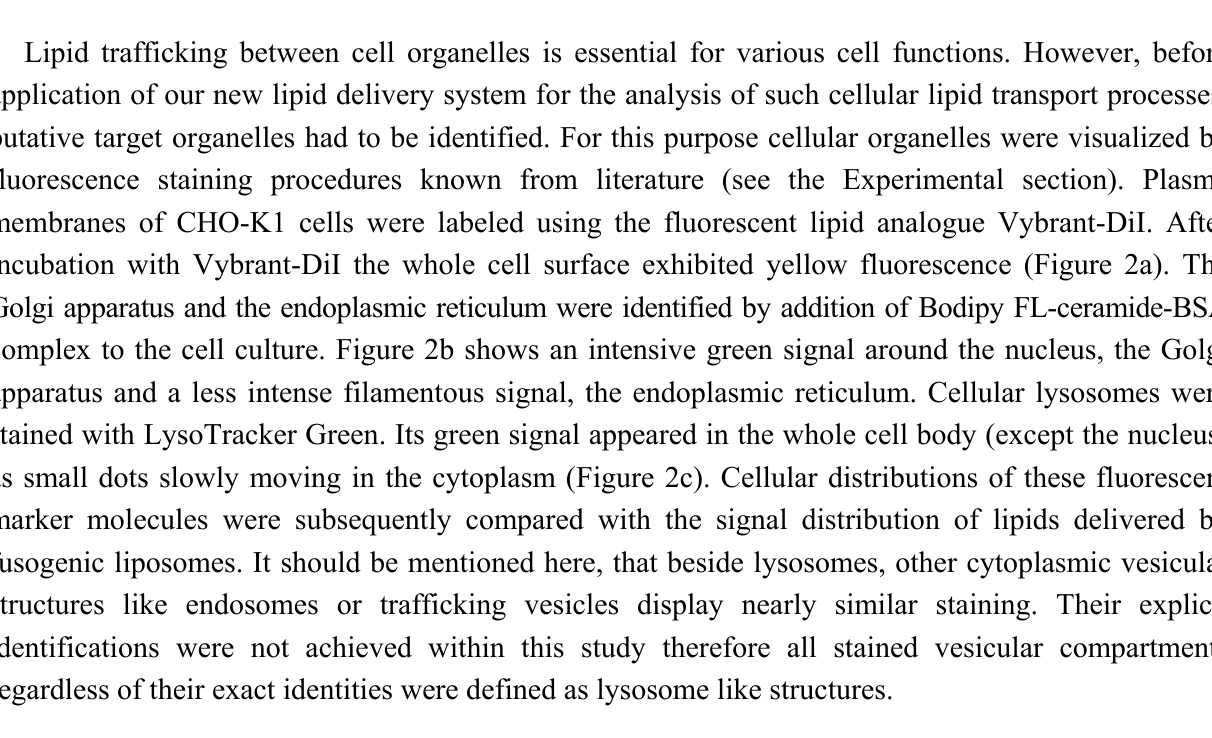
Figure 2. Identification of cellular organelles using organelle specific fluorescent markers.